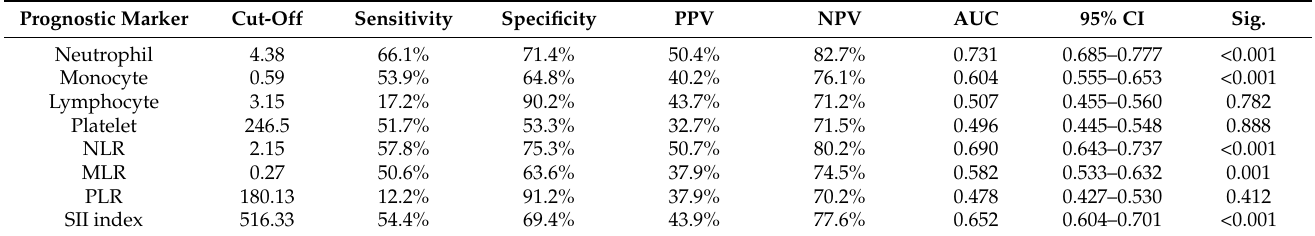
Table 6. Prognostic accuracy of white blood cells, platelets and Inflammatory Ratios.